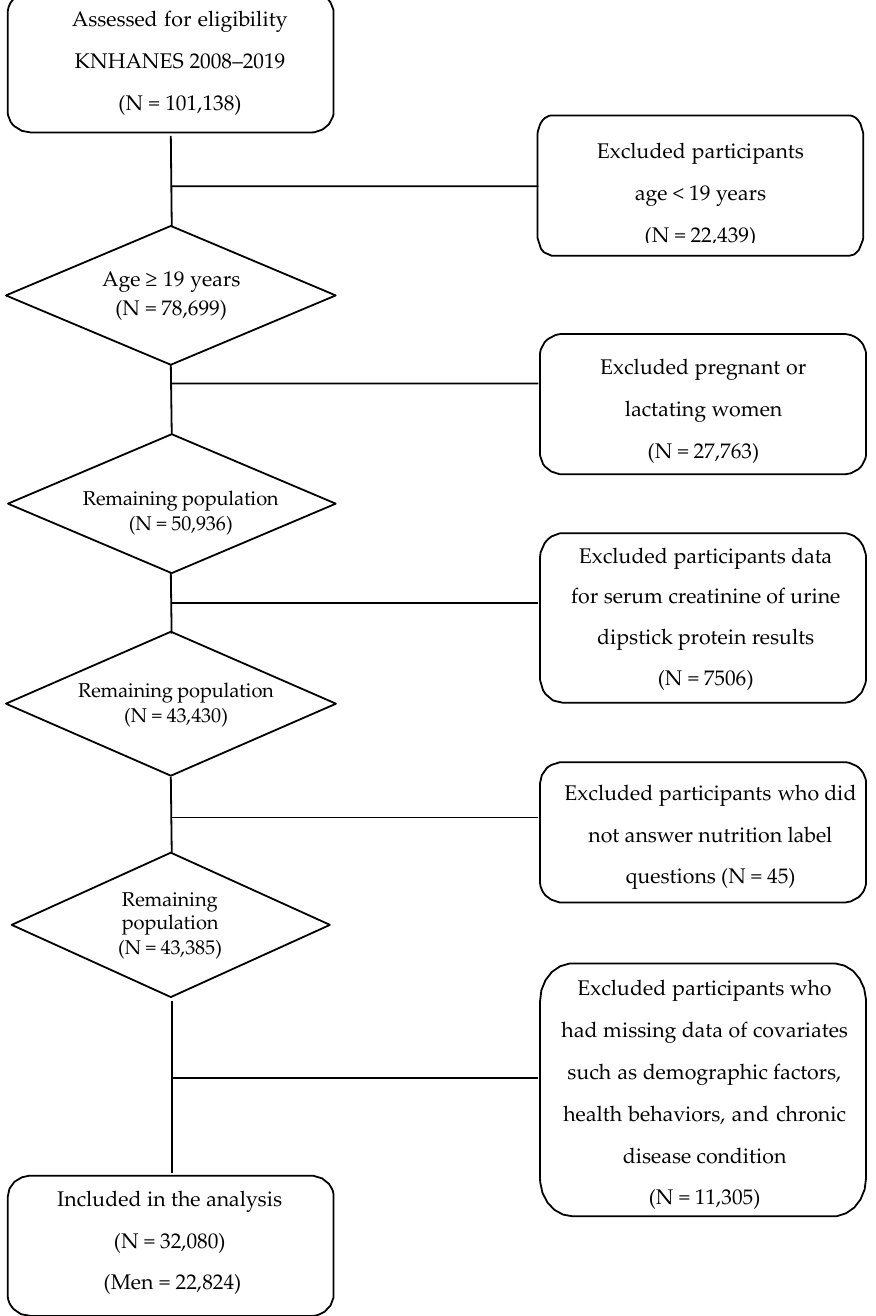
Figure 1. A flow diagram of the study subjects.